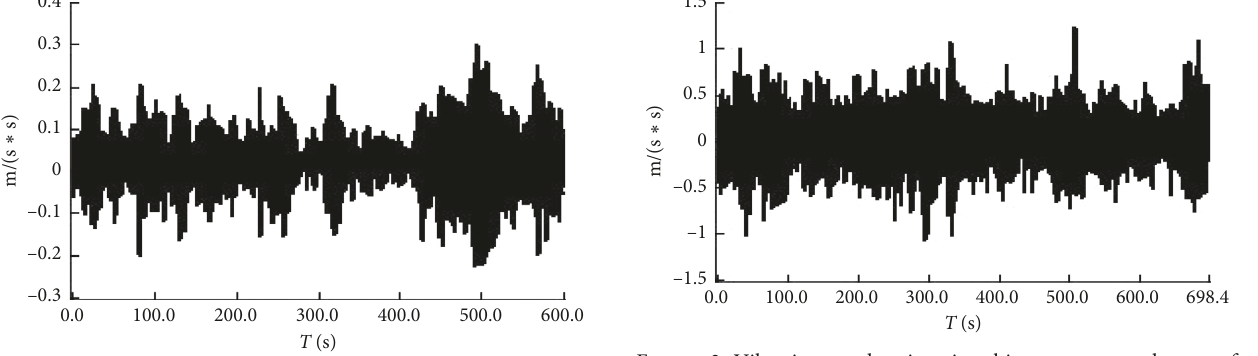
Figure 1: Vibration acceleration time-history curve at the top of No. 1 tower in working conditions at wind speeds of 7–10 m/s.